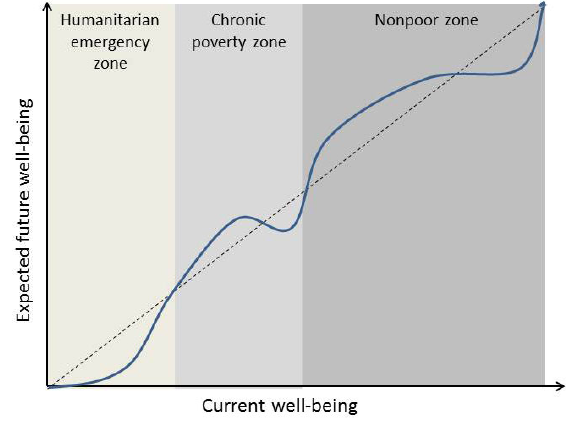
Fig. 2 . Development resilience theory (Barrett and Constas